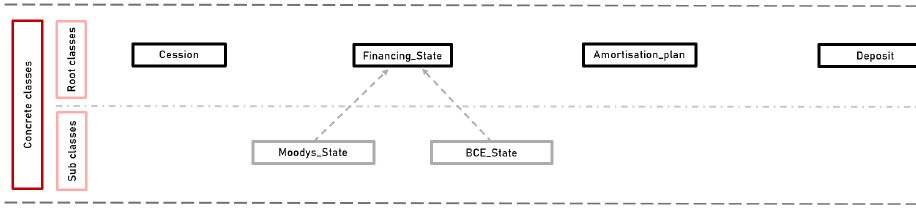
Figure 4. Concrete Layer for the running example.